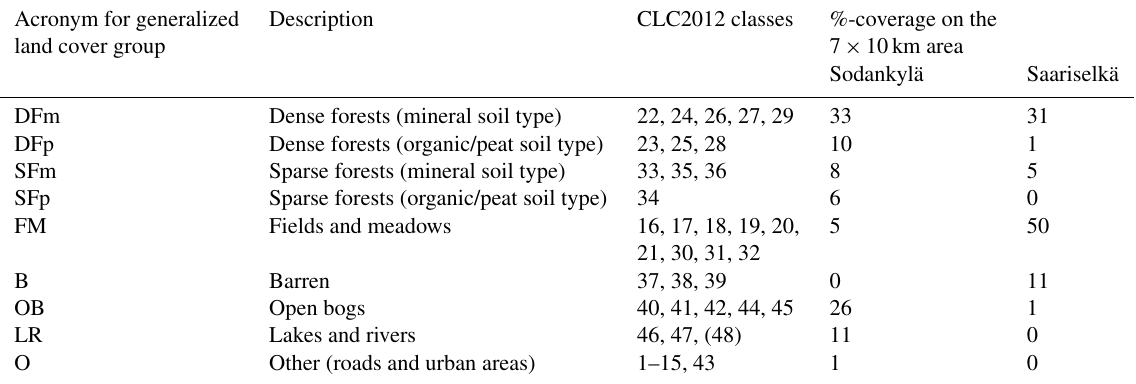
Table 1. Generalization of the field measurements based on the CLC2012 land cover classes analogous to Lemmetyinen et al. (2015), and the spatial %-coverage of each land cover group within a 7km × 10km area in the Sodankylä and the Saariselkä test sites. Acronym for generalized